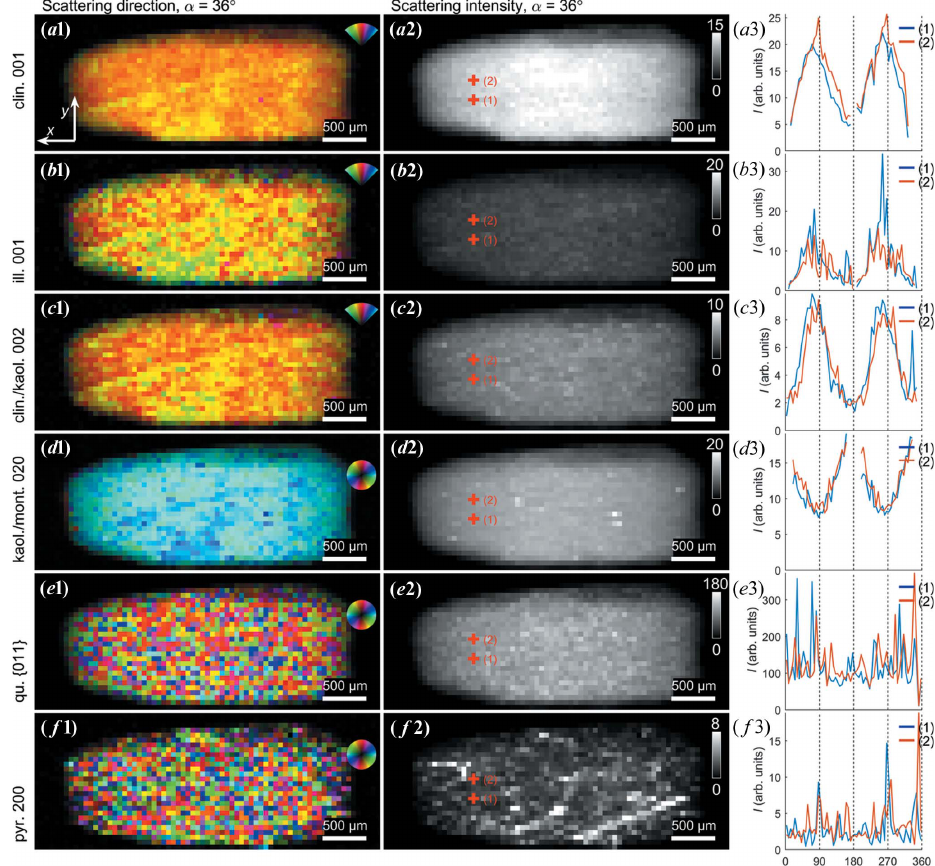
Figure 3 Orientation, intensity and orientation distribution of selected Bragg diffraction peaks, observed for the projection angle (cid:3) = 36 (cid:6) . Note the band-like orientation feature stretching diagonally across the sample. ( a 1) Dominant scattering direction for the clinochlore 001 Bragg peak, colour coded as shown in the inset. ( a 2) Azimuthally integrated intensity of the clinochlore Bragg peak. ( a 3) Azimuthal intensity variations for two points indicated in ( a 2). ( b )–( f ) Similarly for the illite 001, clinochlore 002/kaolinite 002, kaolinite 020/montmorillonite 020, quartz {011} (overlapping with clinochlore and illite) and pyrite {200} Bragg peaks,